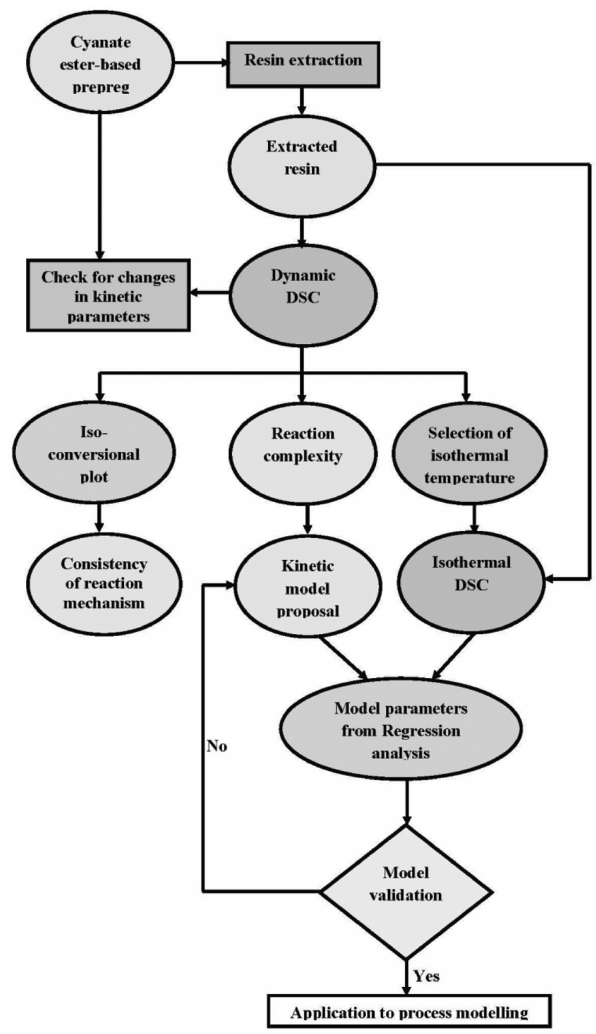
Figure 1: Work plan.